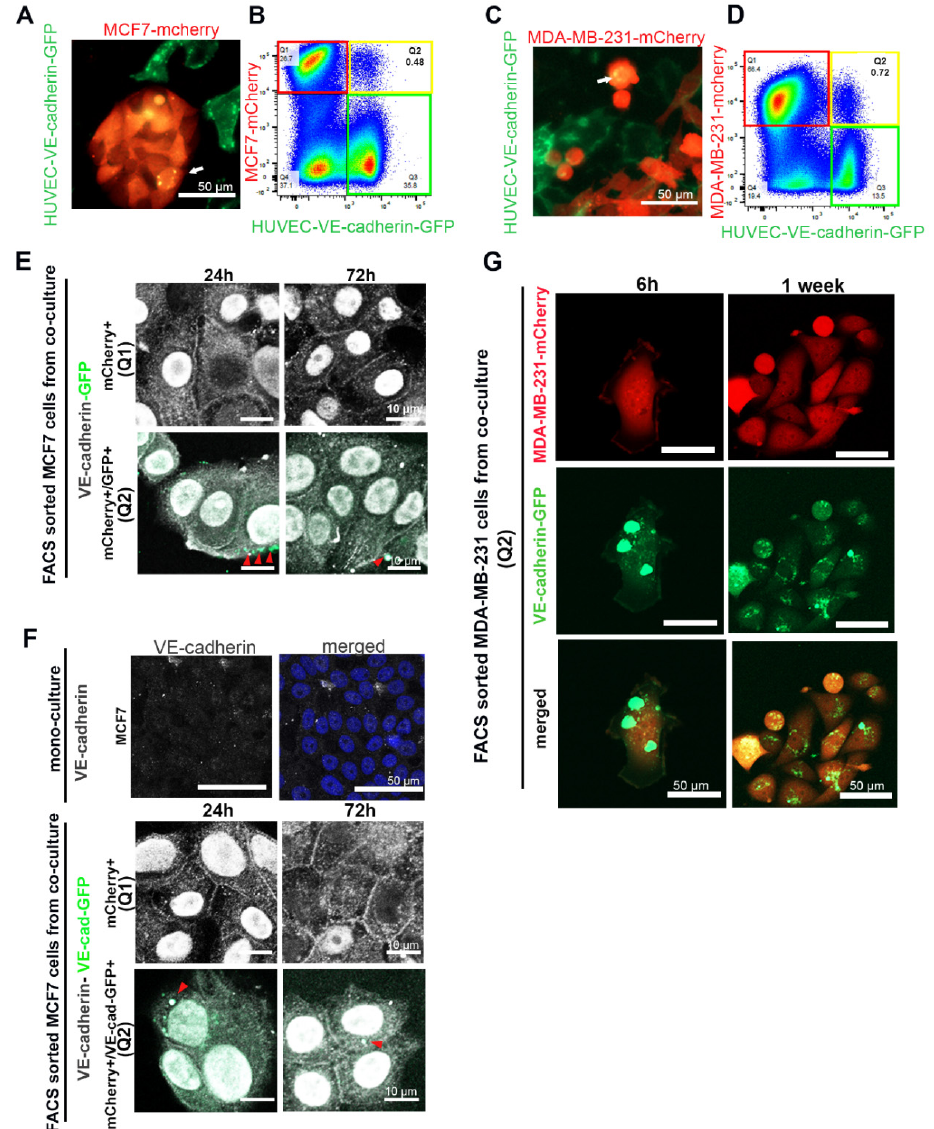
Figure 5. Cancer cells took up VE-cadherin from HUVECs. ( A ) MCF7-mCherry or ( C ) MDA-MB-231-mCherry were co-cultured with HUVECs expressing VE-cadherin-GFP. The arrows show VE-cadherin-GFP-containing vesicles that were taken up in breast cancer cells. ( B ) MCF7-mCherry or ( D ) MDA-MB-231-mCherry co-cultured with HUVEC-VE-cadherin-GFP for 72 h were analyzed by flow cytometry. Red frames denote the mCherry-positive cell population Q1 (MCF7 or MDA-MB-231 cells), green frames indicate VE-cadherin-GFP-expressing HUVECs, and yellow frames highlight the population Q2 of mCherry +/ GFP + double-positive cells. ( E , F ) After MCF7-mCherry cells were co-cultured for 3 days with ( E ) HUVECs-GFP or ( F ) HUVECs-VE-cadherin-GFP, we isolated mCherry + single-positive cells (Q1) and mCherry +/ GFP + double-positive cells (Q2) and stained them with an antibody against VE-cadherin (C-19) (shown in gray). VE-cadherin localized at cell–cell junctions and in the nucleus of isolated cells. Arrows indicate GFP-positive ( E ) or VE-cadherin-GFP containing ( F ) EC-derived membrane vesicles taken up by MCF7-mCherry +/ GFP + cells. These vesicles were also positively stained for VE-cadherin by immunofluorescence staining (gray intensity). MCF7 cell monoculture was used as a negative control for VE-cadherin staining. ( G ) After having been co-cultured with VE-cadherin-GFP-expressing HUVECs for 72 h, MDA-MB-231-mCherry cells were isolated with FACS and cultured for 1 week in the absence of HUVECs. Even 1 week after isolation, VE-cadherin-GFP vesicles could be detected in the MDA-MB-231